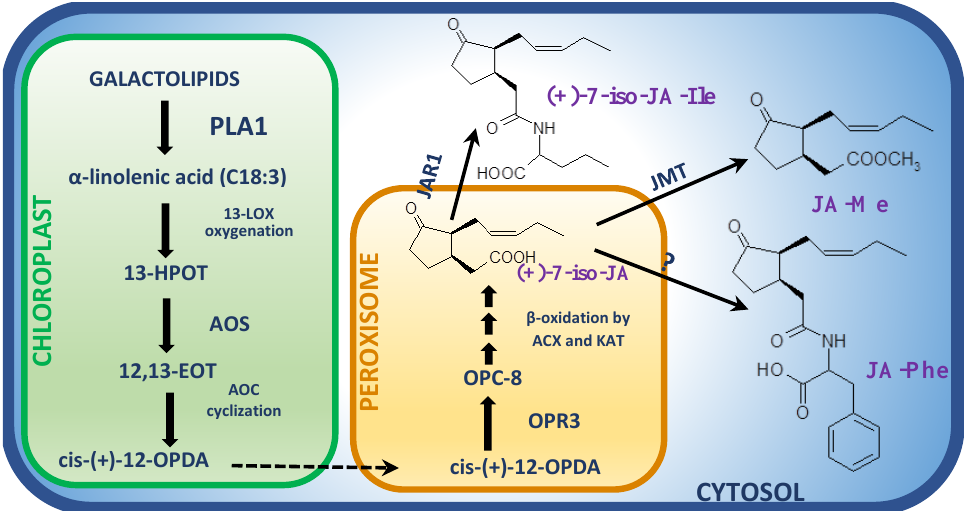
Figure 1. Biosynthesis pathway of jasmonates in Arabidopsis active during necrotrophic interac- tions [1 – 3,9,30,32 – 35]. Detailed description in the text. Abbreviations: ACX, acyl-CoA oxidase; AOC, allene oxide cyclase; AOS, allene oxide synthase; 12,13-EOT, 12,13(S)-epoxy-9(Z),11,15(Z)-octadeca- trienoic acid; (+)-7-iso-JA, (+)-7-iso-jasmonic acid; (+)-7-iso-JA-Ile, (+)-7-iso-jasmonoyl-L-isoleucine; JMT, JA carboxyl methyl transferase; JAR1, Jasmonate-Resistant synthase; JA-Me, methyl ester of JA; JA-Phe, jasmonoyl-phenylalanine; 13-HPOT, (13S)-hydroperoxy-octadecatrienoic acid; KAT, l- 3-ketoacyl-CoA thiolase; 13-LOX, 13-lipoxygenase; OPC-8, 3-oxo-2- (2′ -[Z]-pentenyl)cyclopentane- 1-octanoic acid; cis-(+)-12-OPDA, cis-(+)-12-oxo-phytodienoic acid; OPR3, 12-oxo-phytodienoic acid reductase; PLA1, phospholipase A1.